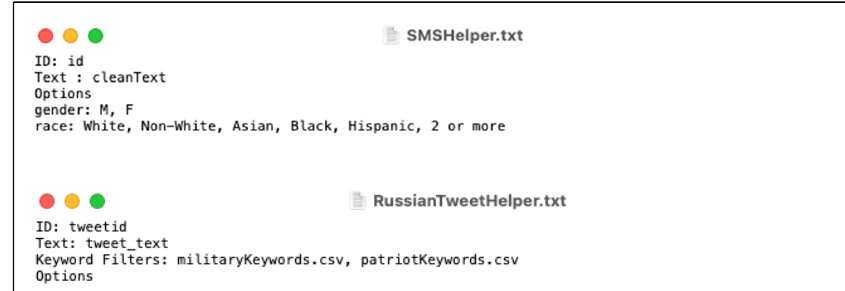
Figure 1. Sample parameter files for text messages and tweets.